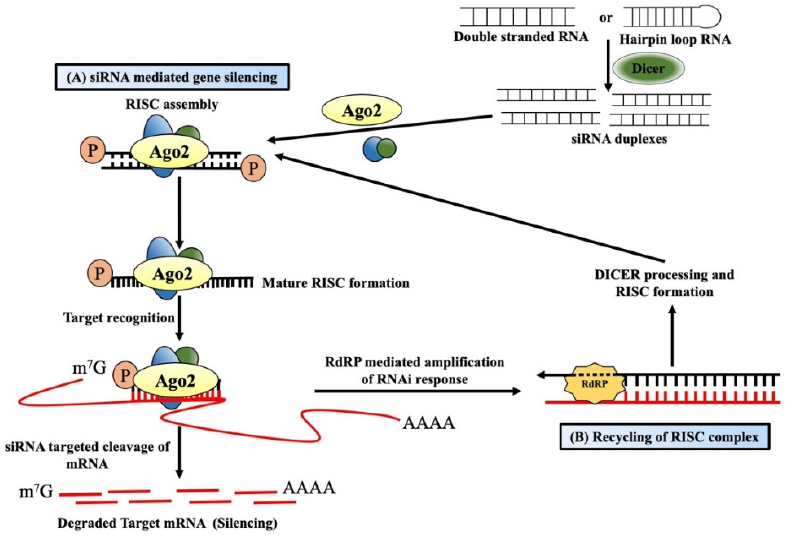
Figure 1. Mechanism of short-interfering RNA-mediated gene silencing. ( A ) Long double-stranded RNAs/hairpin loop RNAs from alien genes are processed into short interfering RNAs (siRNAs) by the Dicer/TRBP (the human immunodeficiency virus transactivating response RNA binding domain) complex and finally become incorporated into RNA-induced silencing complex (RISC). One strand (passenger strand) is degraded from the RNA duplex, and the other strand (guide strand), along with argonaute 2, forms the active RISC. The guide strand guides the active RISC to target and cleaves the complementary mRNAs into the cytosol, resulting in gene silencing. ( B ) RNAi response in plants and worms generally becomes amplified by the RNA-dependent RNA polymerase enzymes (RdRPs). RdRPs and RISC use targeted mRNAs as a template to generate double-stranded RNAs dsRNAs, which then are processed by the Dicer into secondary siRNAs. These siRNAs even- tually amplify the RNAi effect in the system.